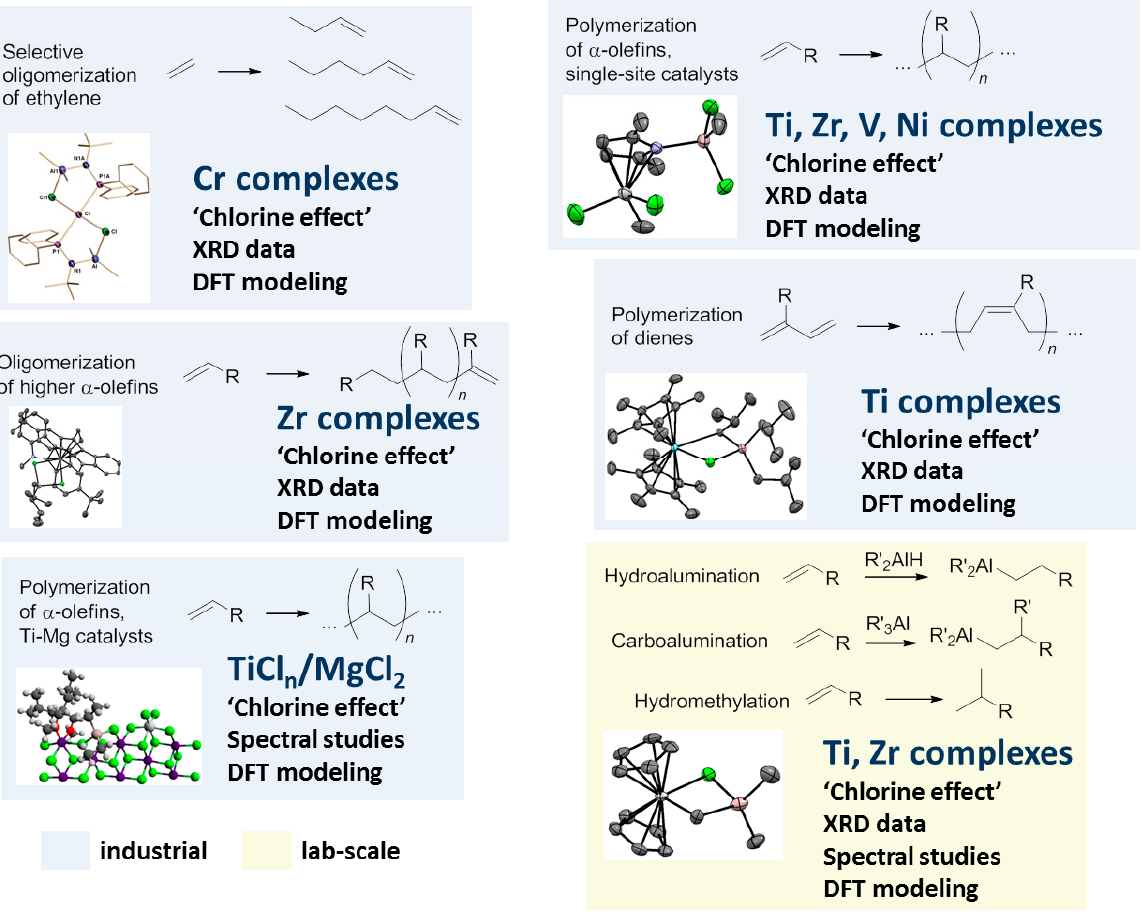
Figure 1. The reactions of α -olefins and dienes with the possible participation of M–( μ -Cl)–Al spe- cies.